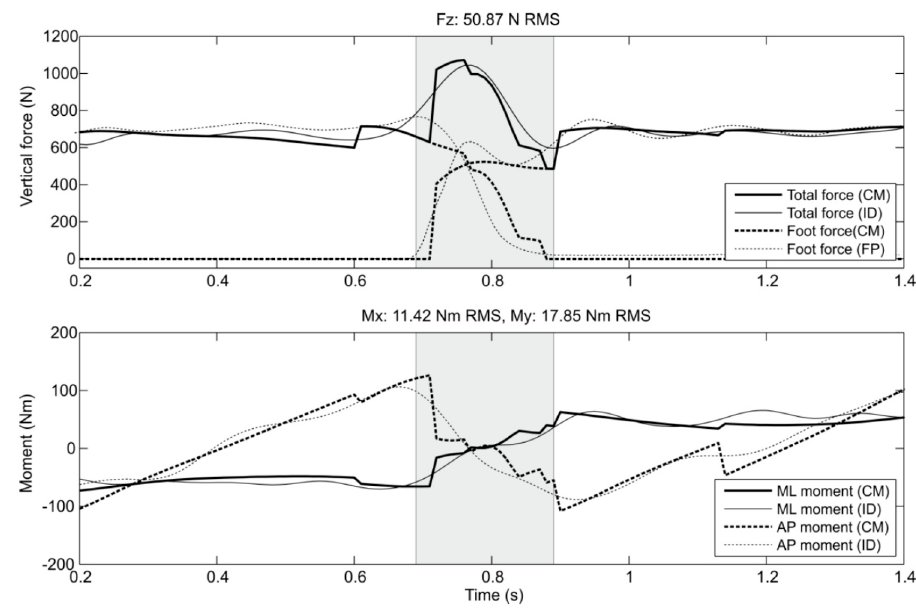
Figure 5. Comparison of the vertical force and the medial-lateral (ML) and anterior-posterior (SP) moments obtained from FCM (CM) and ID with forceplate (FP) measurements (after moments obtained from FCM (CM) and ID with forceplate (FP) measurements (after [46]).